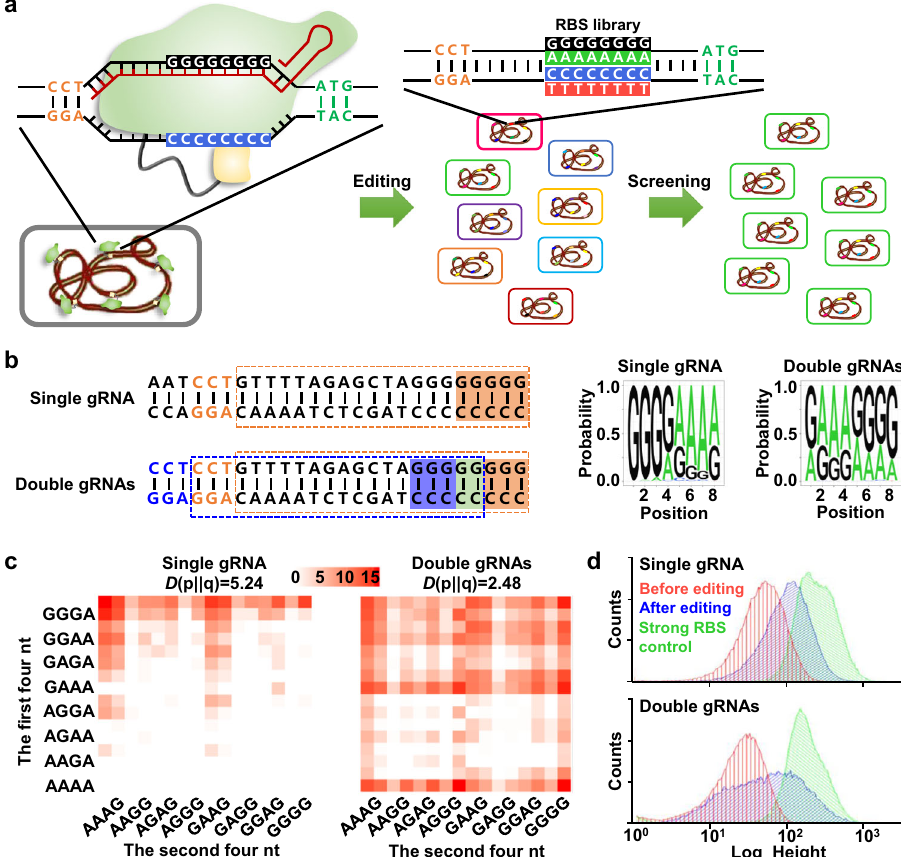
Fig. 1 General work fl ow and validation of BETTER for generating genetic combinations and diversifying gene expression. a BETTER repurposes CRISPR- guided nCas9-cytidine deaminase fusion to generate G/A-rich RBS libraries from tailored starting RBSs with eight consecutive Gs and produce variant cells with different phenotypes. b A single gRNA leads to predominant editing of the fi ve Gs distal to PAM while two interlaced gRNAs lead to less biased editing of eight Gs. A set of PAM, gRNA, and editing window is shown in the same color. The two Gs shaded in green are covered by two editing windows (blue and orange). Three colonies were used for base editing and the cells were mixed with an equal proportion before extraction of genomic DNAs, PCR ampli fi cation, and NGS. c The matrixes show the coverage and discreteness of 256 G/A-containing RBS variants in the RBS libraries generated by BETTER with single or double gRNAs. KL divergence was used to evaluate the discreteness of genetic combinations. Scale bar represents log 2 (relative proportion). d Strength of the RBS libraries generated by BETTER was analyzed for GFP expression by fl ow cytometry. A strong RBS (GAAAGGAG) was used as a control. Source data underlying Fig. 1c are provided as a Source Data fi